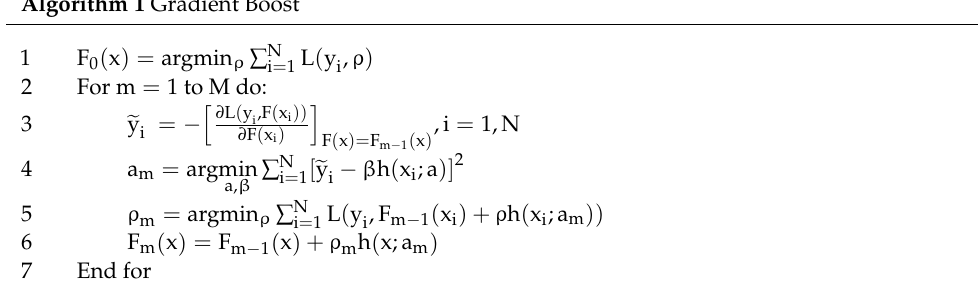
Algorithm 1 Gradient Boost